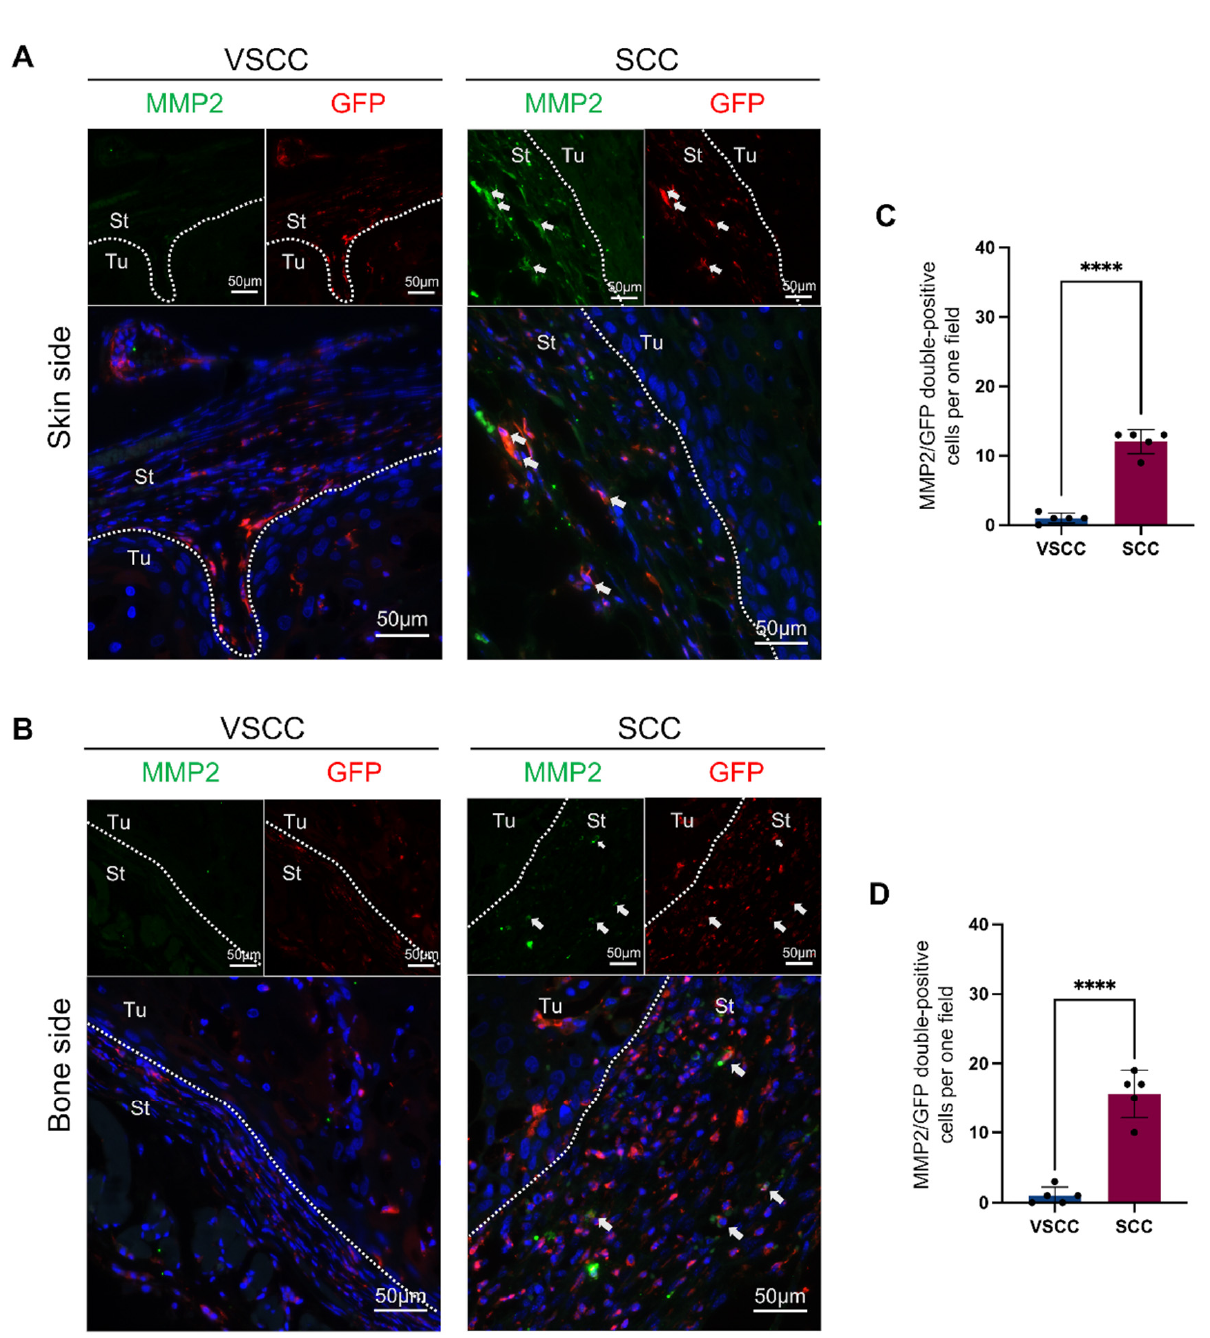
Figure 4. GFP/MMP2 double-positive BMDCs localized in the periphery of SCC-PDSX: ( A ) Repre- sentative images of GFP/MMP2 double-IHC staining on the skin side of tumors; ( B ) Representative images of GFP/MMP2 double-IHC staining at the skin side of tumors; ( C ) Comparison of GFP/MMP2 double-positive cells per one field ( × 400) in skin side of tumors; ( D ) Comparison of GFP/MMP2 double-positive cells per one field ( × 400) in bone side of tumors. Dotted lines represent the bound- ary of the tumor (Tu) and the stroma (St). VSCC, verrucous oral squamous cells carcinoma; SCC, conventional oral squamous cell carcinoma, PDSX, patient-derived stromal cells xenograft. Statistical analyses were performed using Student’s t -test, 2-tailed; **** p < 0.0001. Dots in the plots represent the mean value of each mouse. Data are presented as the mean ± SD, n = 5. 3.4. Stromal Factors IL6 and IL1B May Be Involved in the Relation of BMDCs and OSCC Inva- sion To elucidate the potential underlying mechanism of stromal factors in the involve- ment of BMDCs in OSCC invasion, DEGs in VSCC and SCC were sequentially analyzed and compared using a microarray (Figure 5A). First, we screened 252 DEGs which have more than 3SD in their expression level. We found that 107 genes were upregulated, and 145 genes were downregulated in SCC stromal cells than VSCC stromal cells (Table S1, 2).